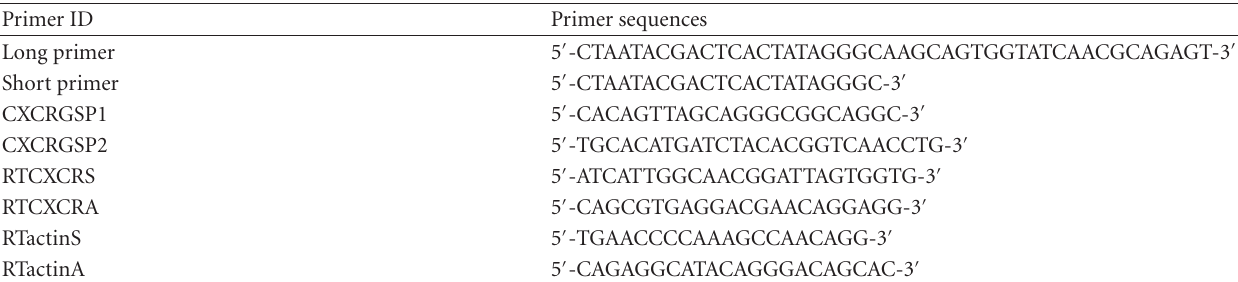
Table 1: Primer sequences used in this